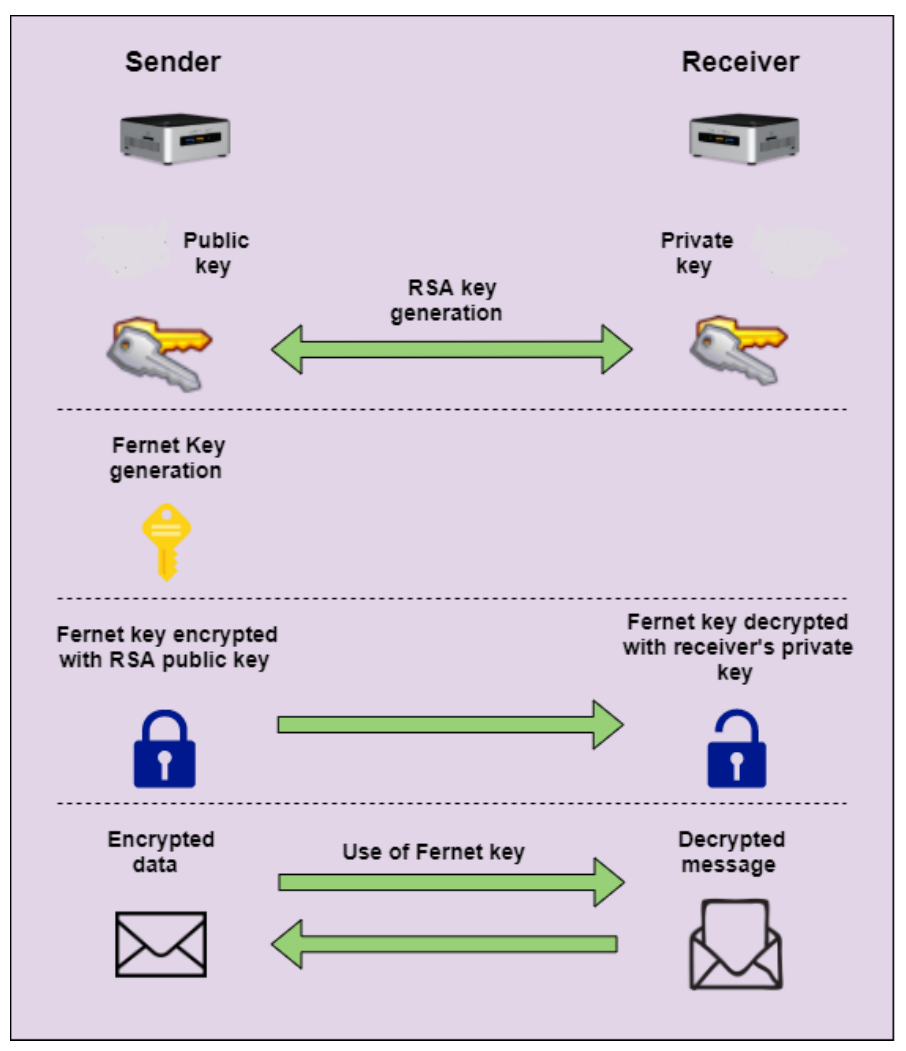
Figure 3. Combination of Farnet and Rivest-Shamir-Adleman (RSA) to encrypt the data at